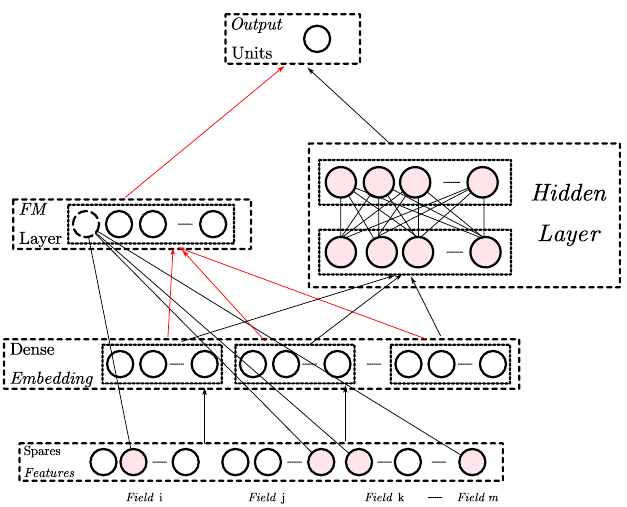
Figure 3. DeepFM